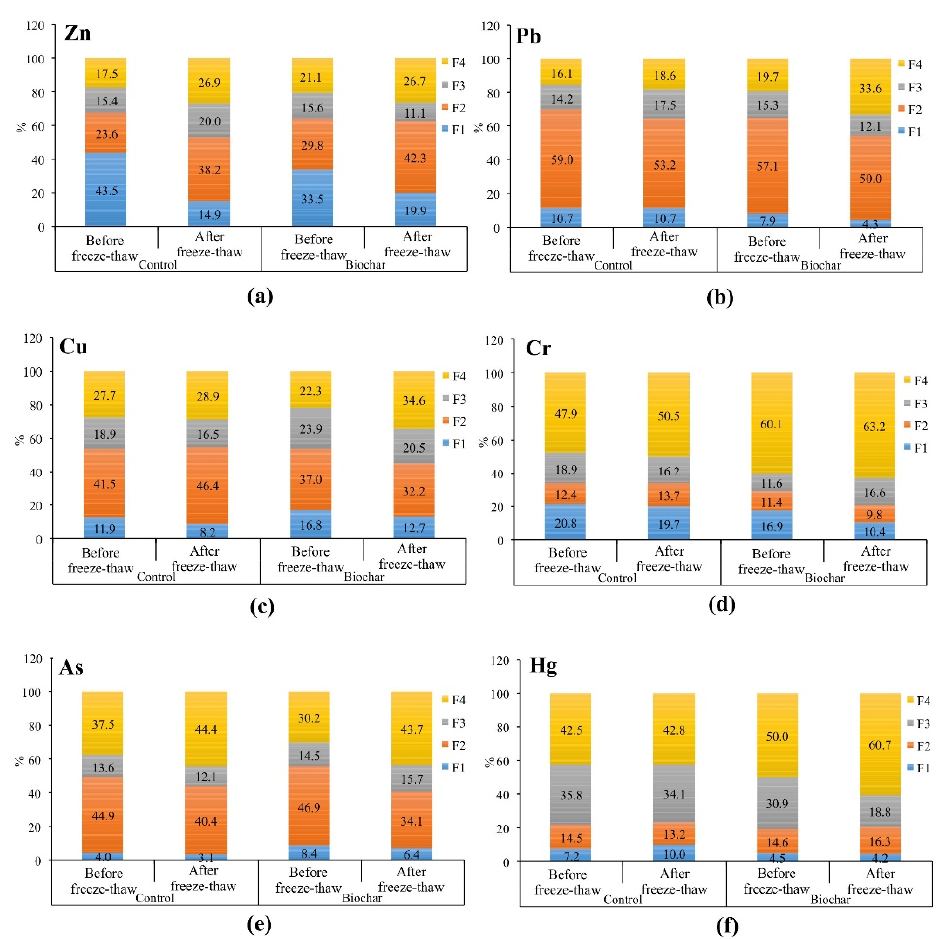
Figure 5. Changes in metal(-loid)s distribution (as percentage of individual fractions: F1—exchangeable and acid-soluble fraction, F2—reducible fraction, F3—oxidizable fraction, F4—residual fraction) in phytostabilized non-amended (control) and biochar-amended soil samples, before and after freeze-thaw. The letters from ( a – f ) indicate the reading order of potentially toxic elements. For an individual metal(-loid) and its specific fraction, values followed by different letters differ significantly in metal(-loid) share in the specific fraction between control and biochar-amended soils, before and after freeze–thaw (ANOVA followed by Tukey’s 401 HSD test, p <